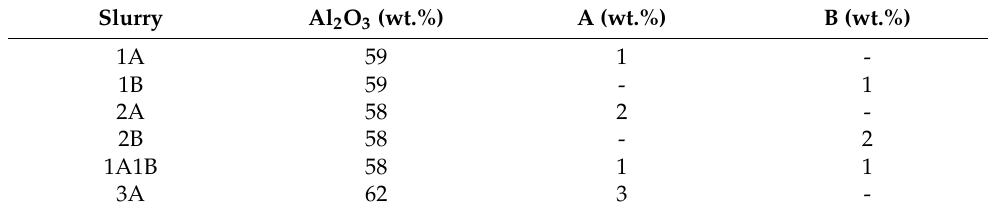
Table 2. Compositions of the alumina